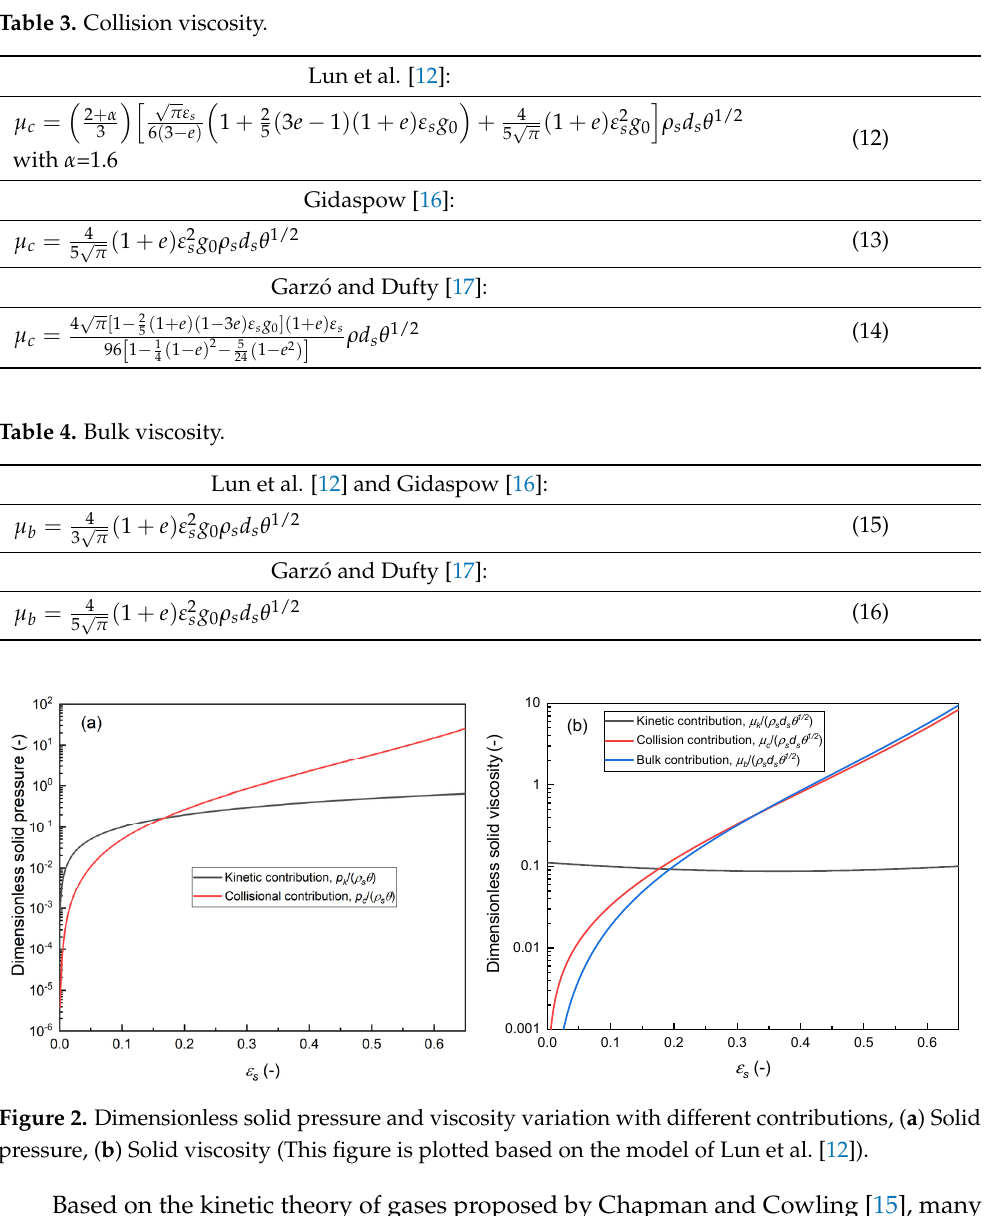
Table 3. Collision viscosity.